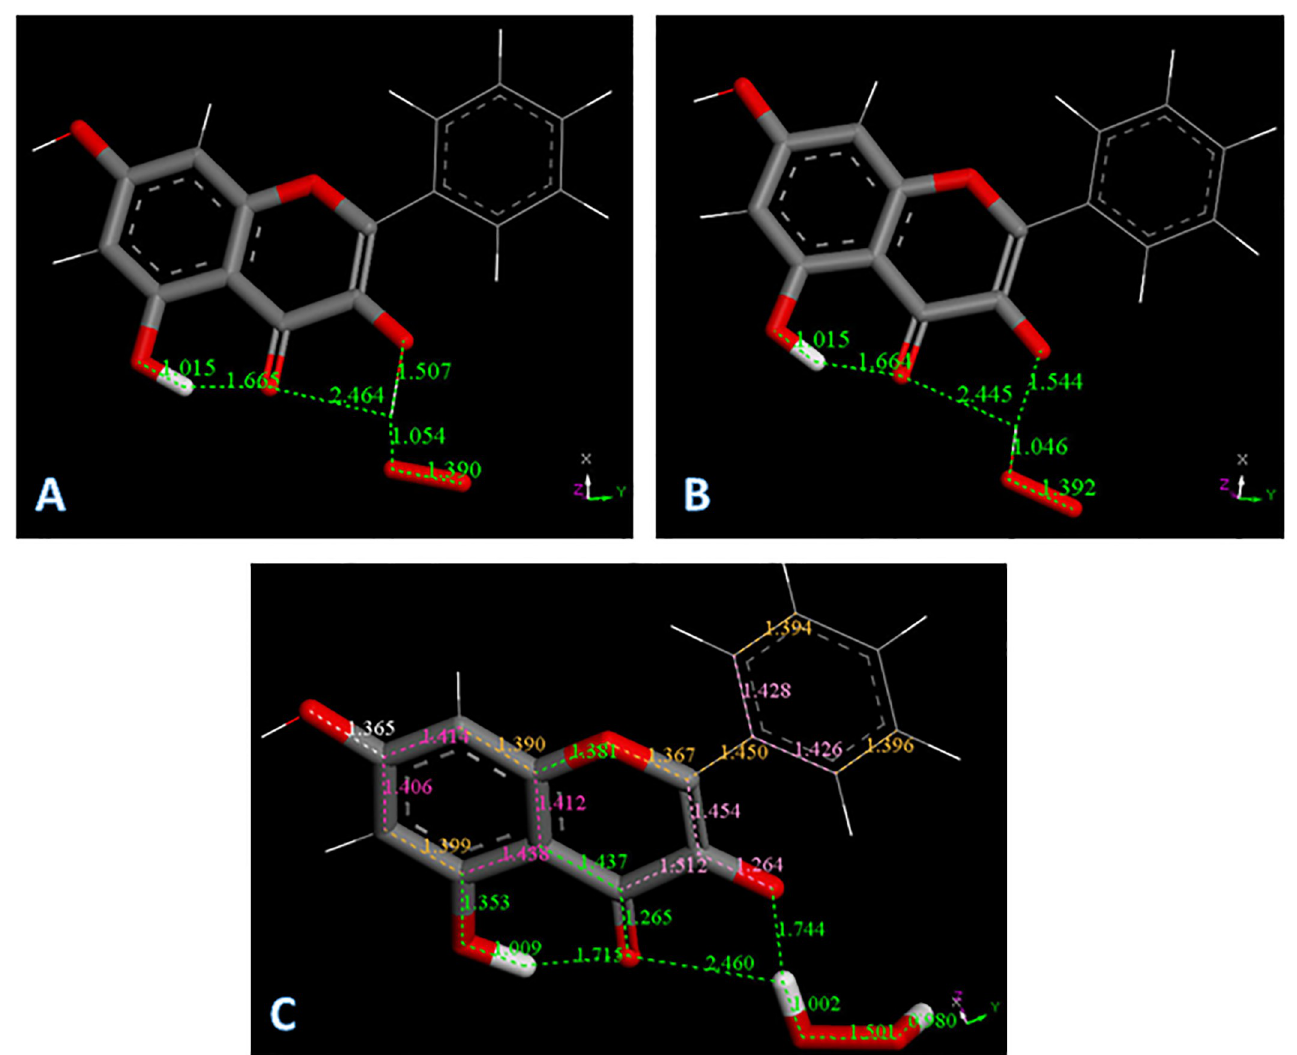
Fig 5. A: Converged DFT minimum for superoxide attack on galangin H3. The galangin O-H3 bond distance elongates to 1.507 Å and H3 advances to establish a bond distance to superoxide, 1.054 Å ; B: Converged DFT minimum for initial van der Waals contact between HO 2 and the radical obtained after excluding H3 from galangin. The galangin radical does not recapture H3, 1.544 Å ; C: The galangin-superoxide complex shown in Fig 5A is van der Waals placed nearby a proton. This is a neutral radical that after minimization shows formation of H 2 O 2 plus the galangin derivative radical, which locates the unpaired electron in the